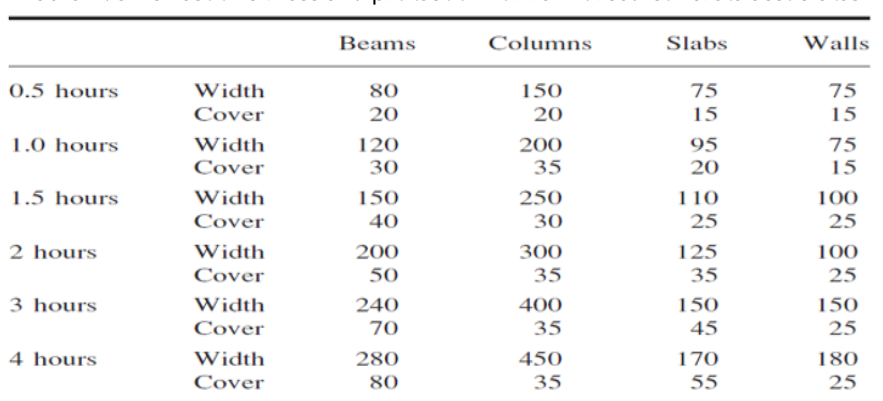
Figure 5. Thermal conductivity (W/mK) and specific heat (J/kgK) of steel at raised temperatures Table 1. Smallest thickness and protection for reinforced concrete